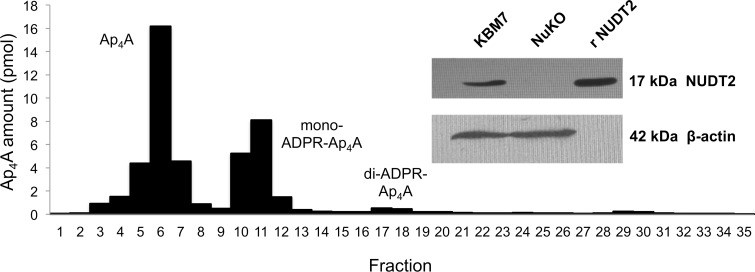
Ion-exchange chromatography of Ap4A extracted from KBM-7-NuKO cells and (inset) western blot analysis of cell extracts for the presence of NUDT2 protein.A nucleotide extract from NuKO cells was subjected to ion-exchange chromatography and fractions assayed luminometrically for Ap4A as described in Materials and Methods. Inset: a sample of recombinant NUDT2 and protein extracts of KBM-7 and KBM-7 NuKO cells were subjected to polyacrylamide gel electrophoresis and subsequent nitrocellulose blots probed for the presence of NUDT2 with rabbit polyclonal anti-NUDT2 (Santa Cruz) followed by detection with HRP-conjugated goat-anti-rabbit IgG and ECL visualization (ECL Select, GE Healthcare). Mouse β-actin was detected with HRP-conjugated goat-anti-mouse IgG (Santa Cruz).